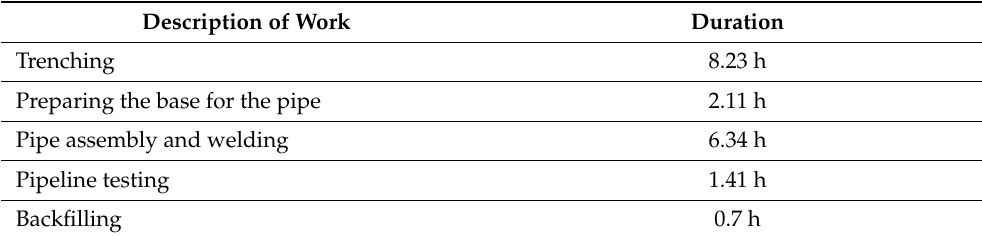
Table 4. Temporary indicators of pipeline laying.